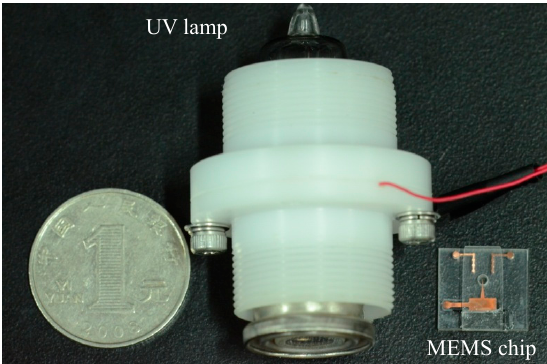
Figure 7. The UV lamp and the microelectromechanical systems (MEMS) chip.